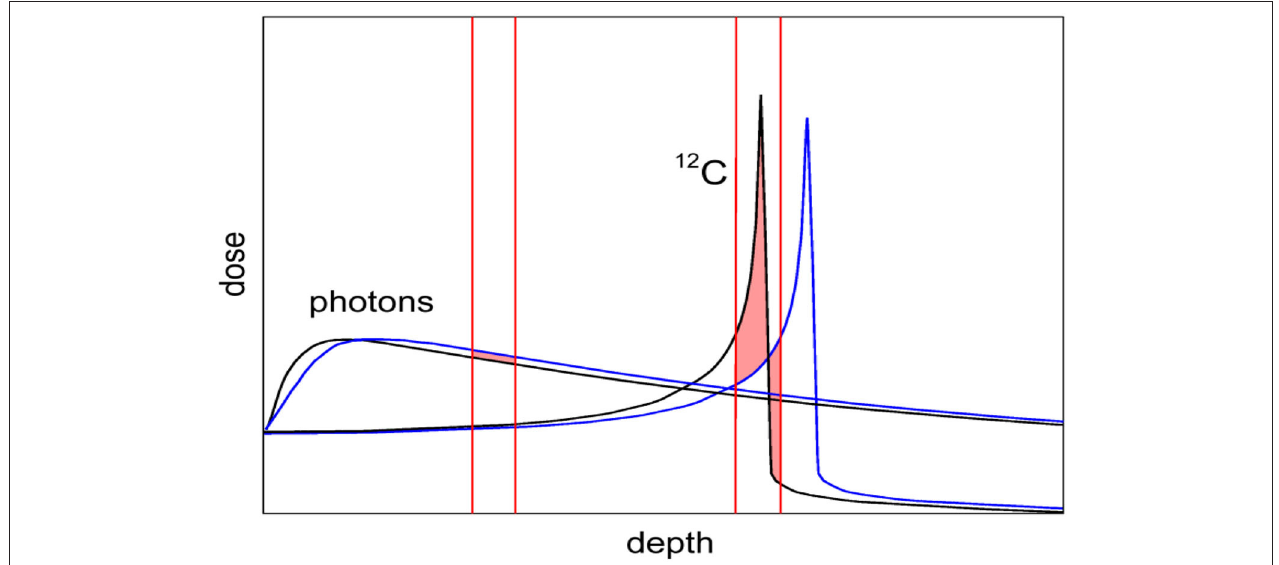
FIGURE 1 | Comparison of depth-dose distribution for heavy ions ( 12 C) and photons (X-rays). The Bragg peak gives the physical advantages of CPT. However, the figure shows that a small range shift caused, e.g., by a tissue inhomogeneity has a small impact on the X-ray curve, but in CPT it can significantly shift the Bragg peak from the target into a sensitive organ surrounding the